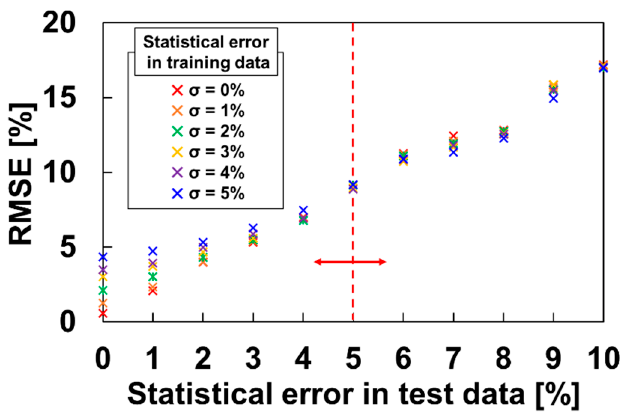
Figure 7. Difference in analytical performance (root mean square error (RMSE)) for the test data with random errors ( σ = 0 − 10%). The training data with random errors ( σ = 0 − 5%) were used to build the machine learning (ML) model using